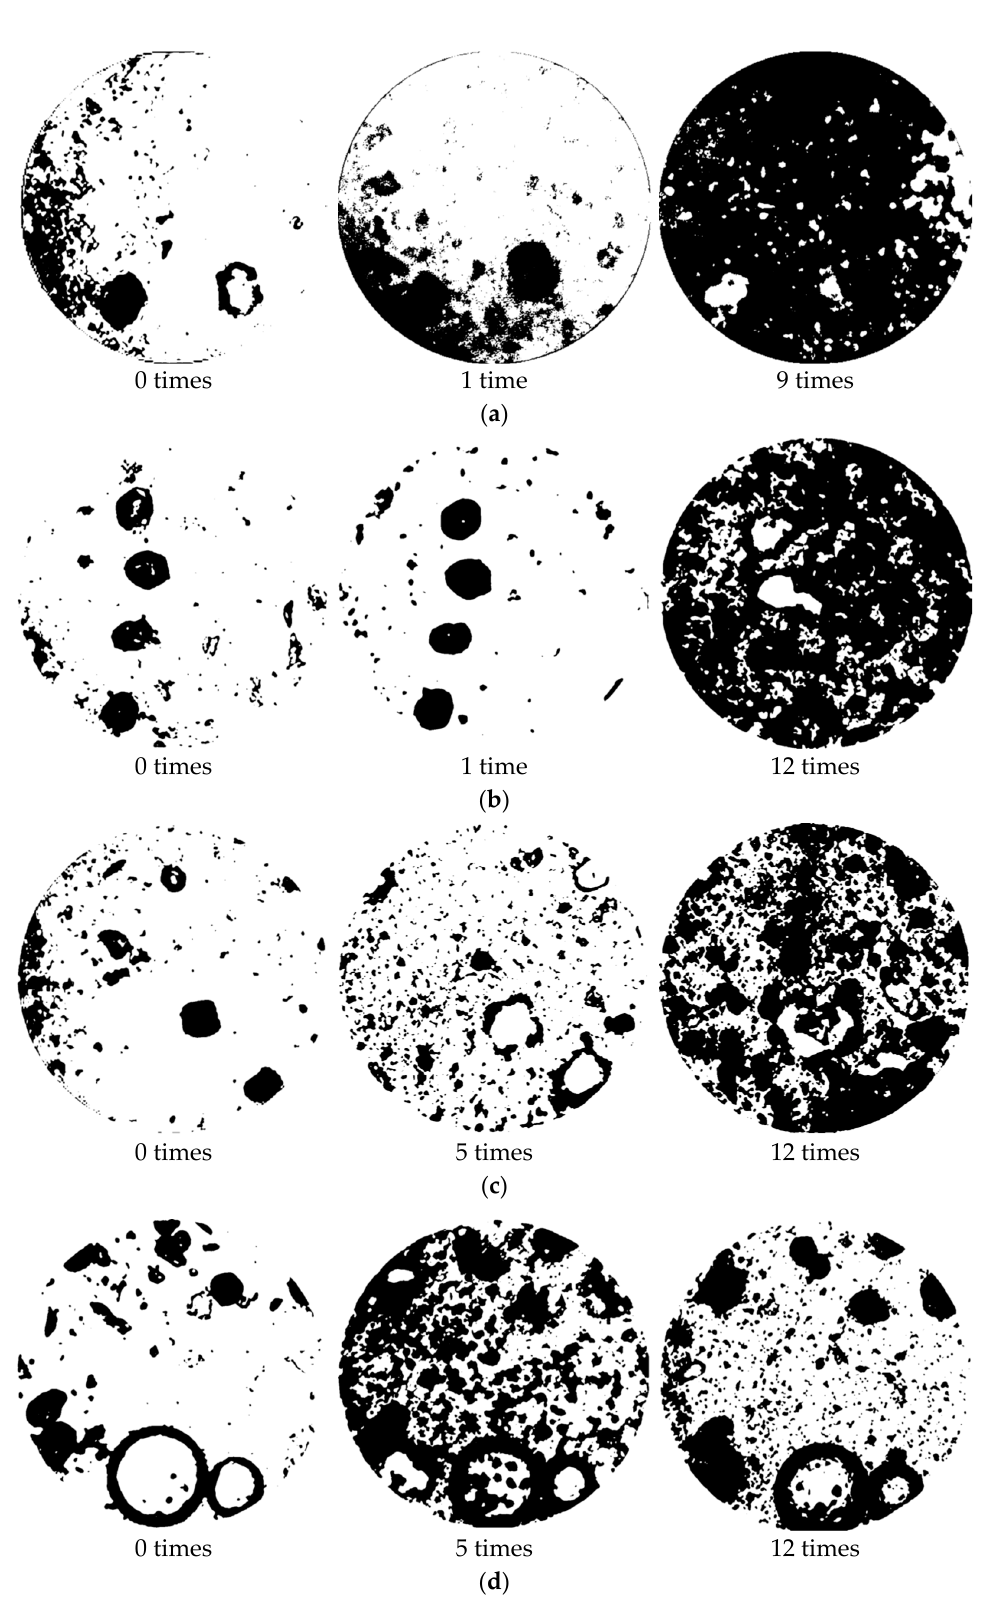
Figure 7. Surface morphology of the W-OH solid consolidation after binarization treatment: ( a ) W-OH concentration: 4%; ( b ) W-OH concentration: 6%; ( c ) W-OH concentration: 8%; and ( d ) W-OH concentration: 10%.